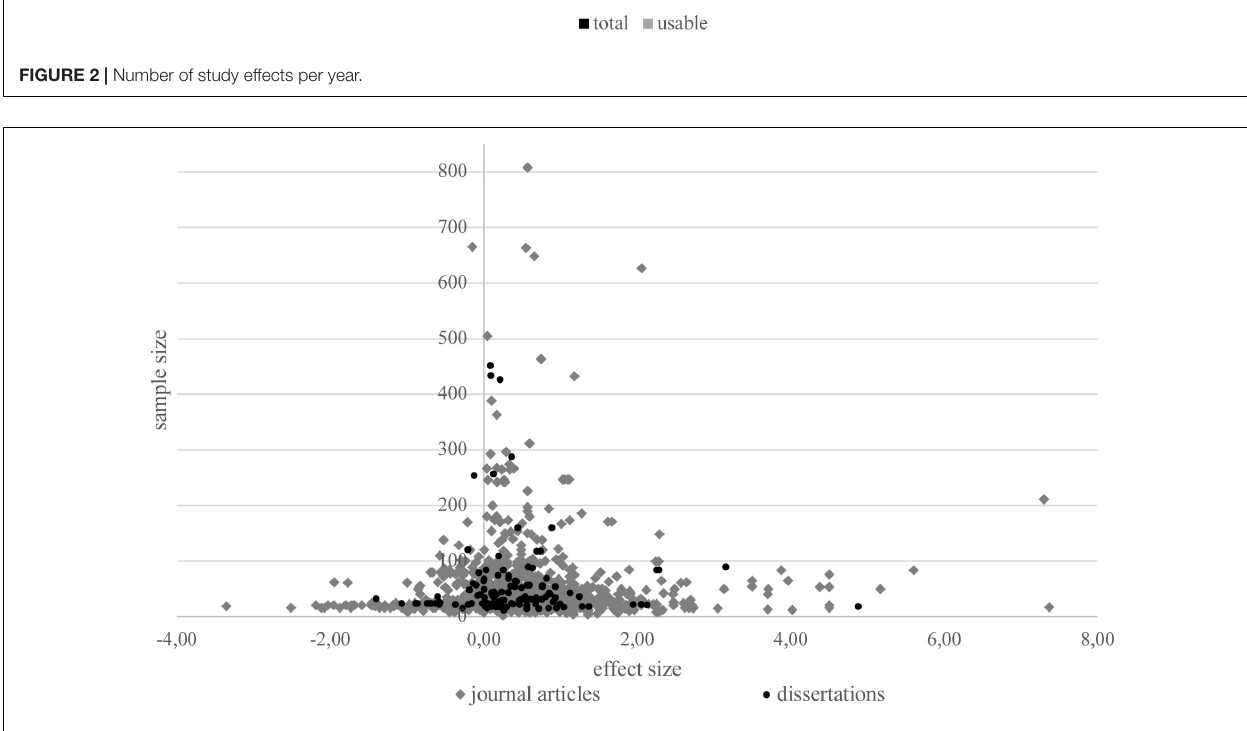
FIGURE 3 | Funnel plot of all study